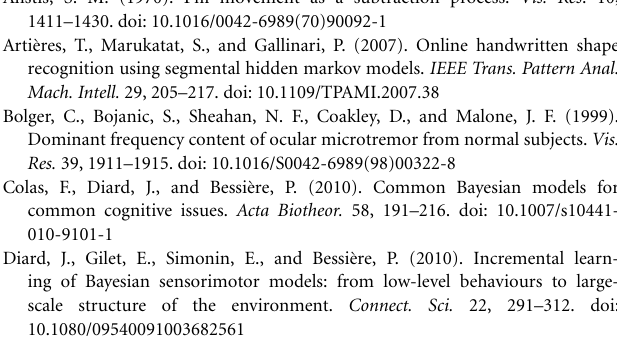
Table 1 | Confusion matrix in the disability assessment experiment. h1 h2 h3 h1 0.8 0.2 0.11 0.81 0.06 0.94 The table is read in rows. For instance, the top row is the average probability distribution over recognized disability level, for all trajectories of healthy users in the learning database. Diagonal values indicate correct